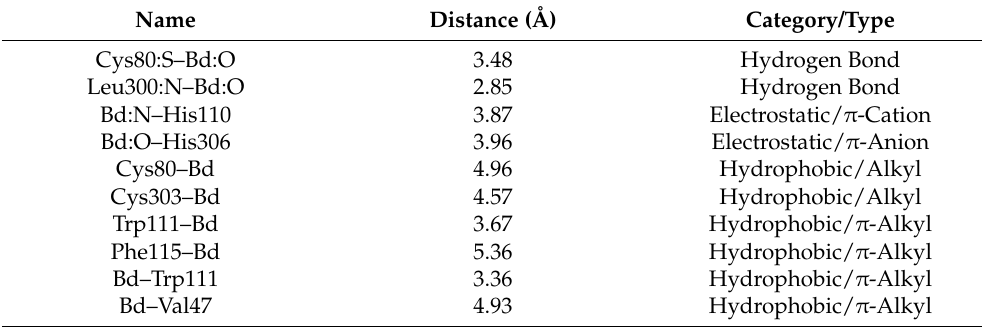
Table 8. Interactions between the deprotonated Bd (C6C15C17-COOH) and the receptor pocket. Complex established by our method (founded on shape